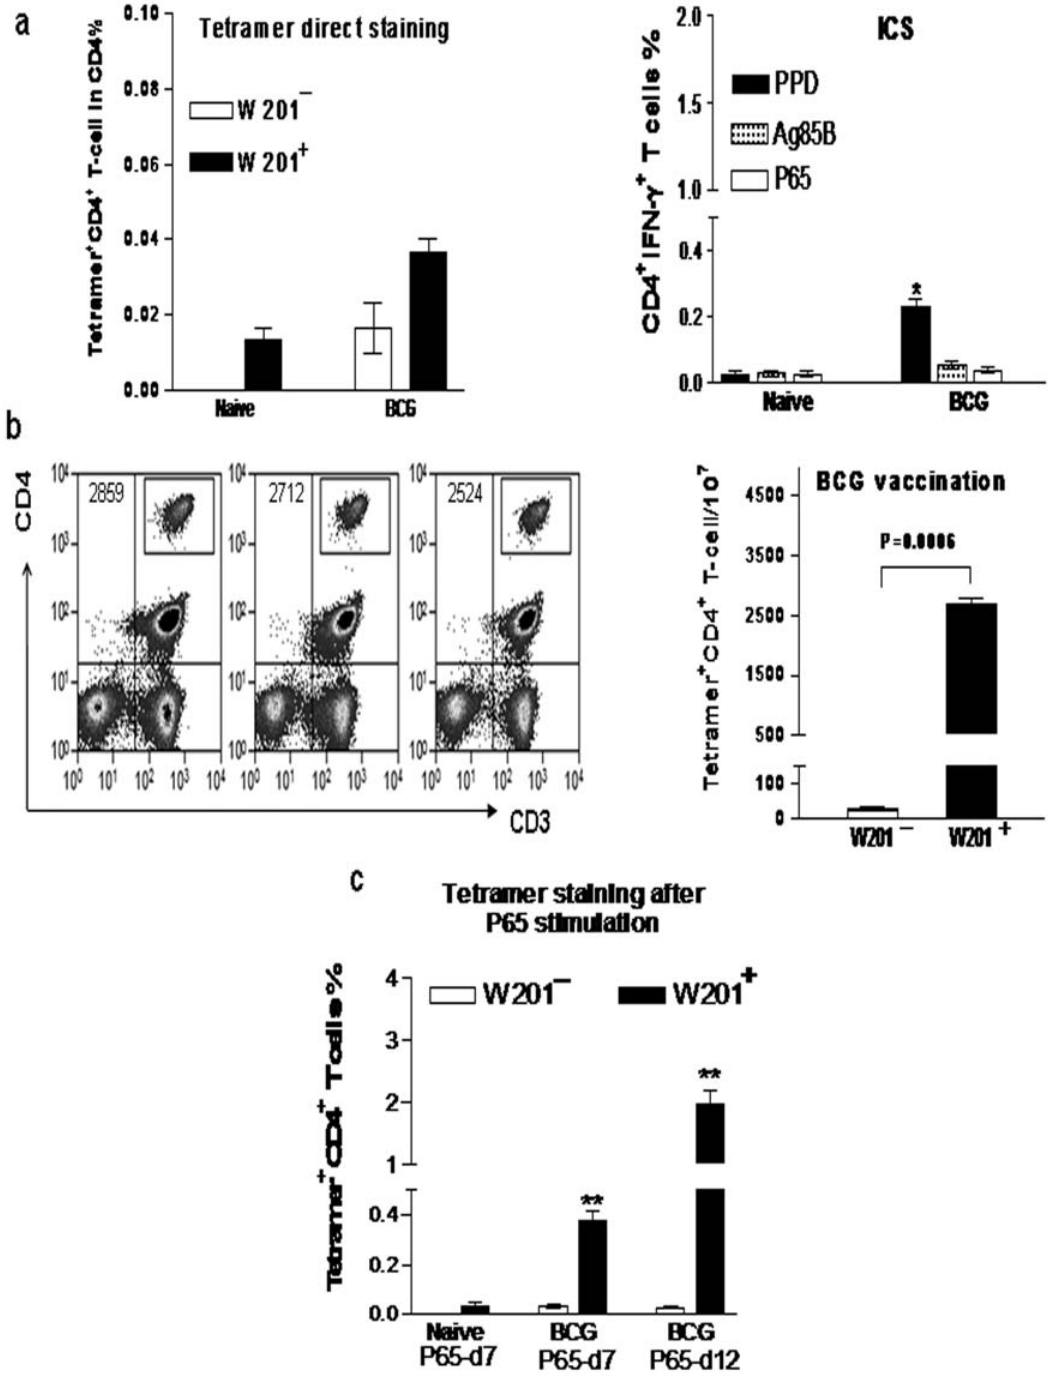
Figure 5. This tetramer-enriched approach detected BCG-elicited resting memory P65-specific CD4 T cells at a frequency of 2-3/ 10,000 in PBL. (a) Left bar graph shows that the frequency of # 0.03% tetramer-bound CD4 + T-cells detected by tetramer direct staining in the BCG- vaccinated Mamu-DRB*W201 + macaques was difficult to distinguish from background staining (p . 0.05). The bar graph on right shows that intracellular IFN- c staining could not detect the epitope-specific IFN- c -producing memory CD4 T cells. (b) The flow cytometry histograms on left show the total numbers of tetramer-bound epitope specific CD4 T cells detected by the tetramer-based enrichment approach in 10 7 PBL from each macaque. The enriched tetramer + CD4 + T-cell population is counted by flow cytometry and displayed in the contour plot in the upper right of the CD4 quadruple, with the total numbers shown in the upper left CD4 quadruple. The bar graph on right shows that this tetramer enriched approach can detect significantly greater numbers of P65-specific CD4 T cells in BCG-vaccinated Mamu-DRB*W201 + macaques than those in the vaccinated Mamu-DRB*W201 - animals. (c) The bar graph shows that the tetramer staining after P65 stimulation detects about ten-fold greater numbers of the BCG-elicited tetramer-bound CD4 T memory cells than without stimulation. The numbers of tetramer-bound cells in PBL from Mamu-DRB*W201 + macaques were significantly greater than those in naı¨ve or BCG-vaccinated Mamu-DRB*W201 - animals (**, p , 0.01).